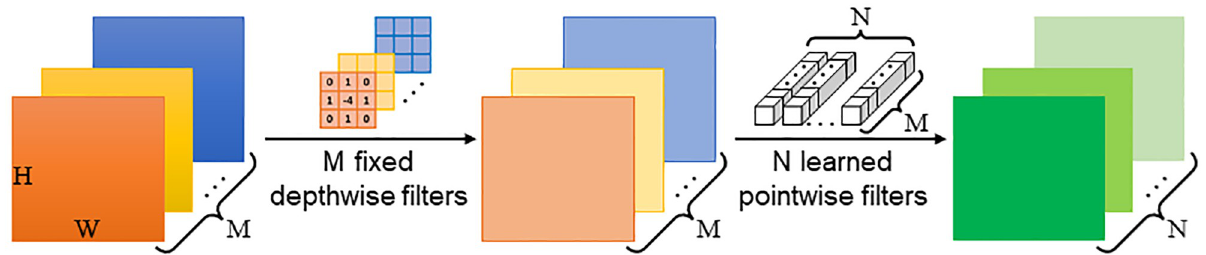
Fig 3. The proposed semi-fixed depthwise separable